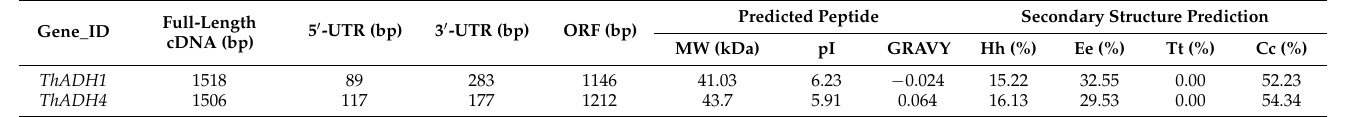
Table 2. Features of the ThADH1 and ThADH4 genes and their protein products.